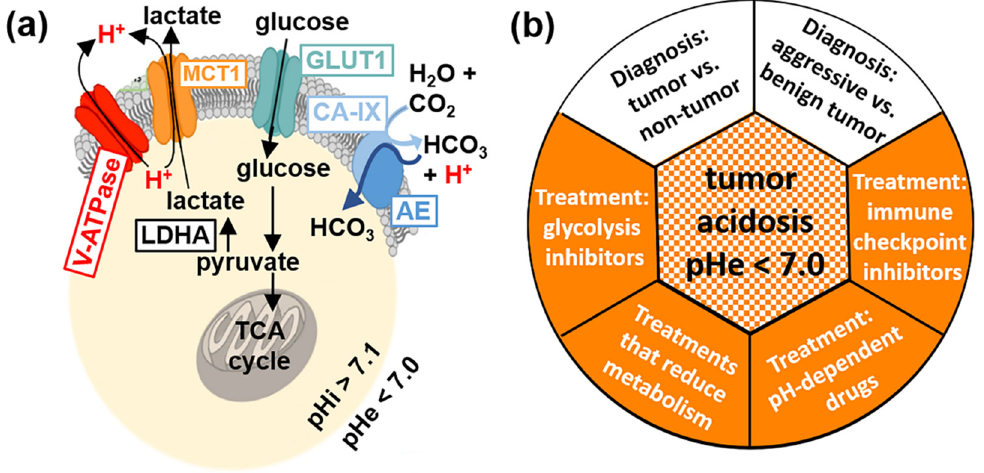
Figure 1. Tumor acidosis. ( a ) The Warburg effect leads to an acidic tumor microenvironment. GLUT1 and other glucose transporters shuttle glucose into the cell, which is metabolized into pyruvate. The pyruvate is then converted into lactate by lactate dehydrogenase (LDHA), and this upregulated glycolysis pathway in tumor cells is known as the Warburg effect. The lactate is then secreted out of tumor cells by MCT1 and other monocarboxylate transporters, along with excess intracellular protons secreted via V-ATPase (red H + , left side). Furthermore, carbonic anhydrase IX (CA-IX) produces bicarbonate that is internalized into cells to neutralize intracellular acidosis caused by the Warburg effect, and the bicarbonate production contributes to extracellular acidification (red H + , right side). These processes lead to an acidic extracellular pH (pHe) relative to intracellular pH (pHi). ( b ) Evaluations of tumor acidosis can have a central role in diagnostic applications (white) and evaluations of anti-cancer treatments (orange).